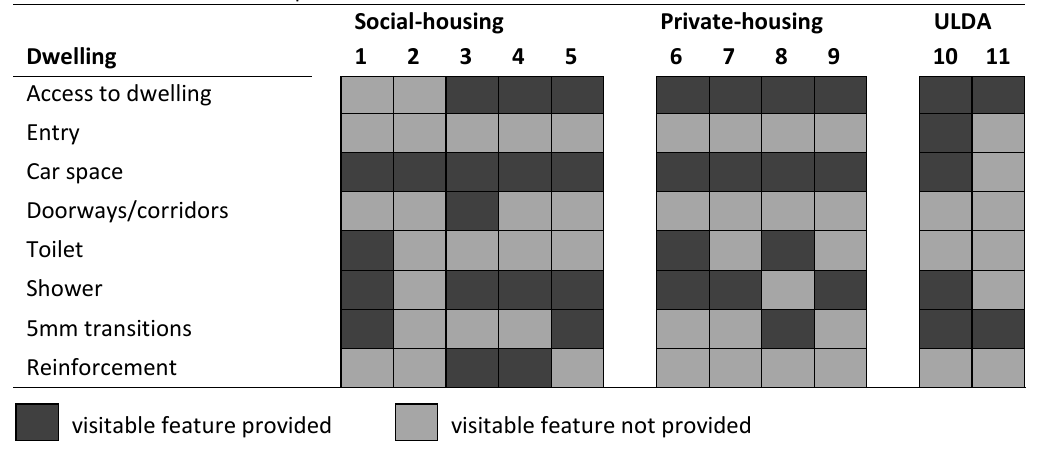
Table 1. Distribution of compliant